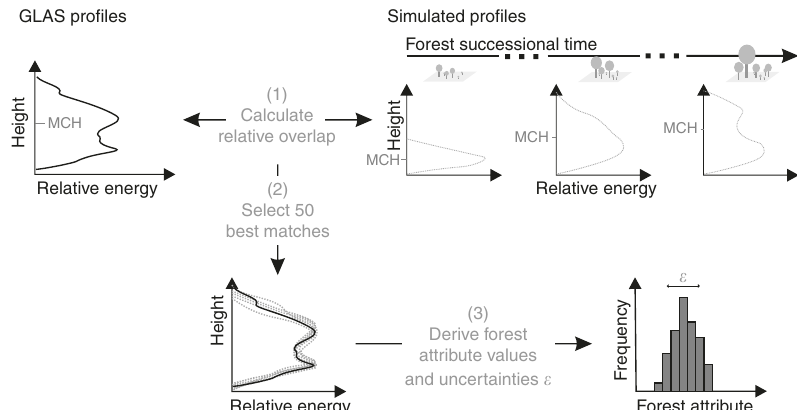
Fig. 1 Work fl ow of our approach at one location in the Amazon. (1) The entire GLAS lidar pro fi le derived from ICESat lidar is matched with simulated pro fi les (100 simulated lidar pro fi les at a 5-year interval over 2500 years of forest succession, 50,000 in total) by calculating their relative overlap. (2) We select the 50 best matches (relative overlap > 70%) between the GLAS pro fi le and the simuletd pro fi les. (3) We then derive simulated forest attributes (e.g., biomass, basal area) for these 50 best matches. The derived probability distribution is used to quantify the uncertainty indices